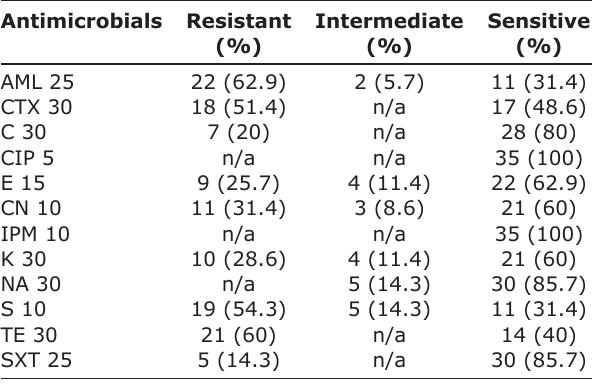
Table-2: Antimicrobial resistance profile of Aeromonas hydrophila isolates (n = 35). Antimicrobials Resistant